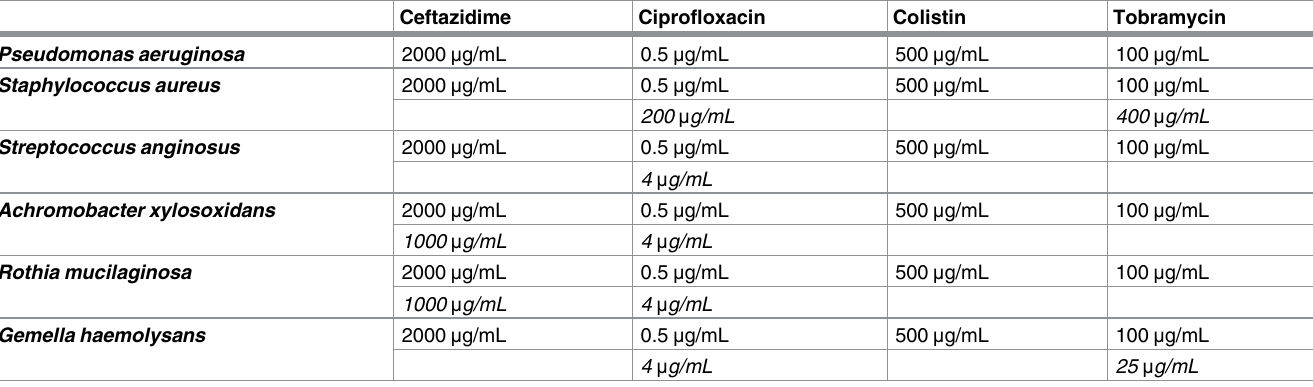
Table 2. Overview of antibiotic concentrations used for quantitative recoveryexperiments. Ceftazidime Ciprofloxacin Colistin Tobramycin Pseudomonas